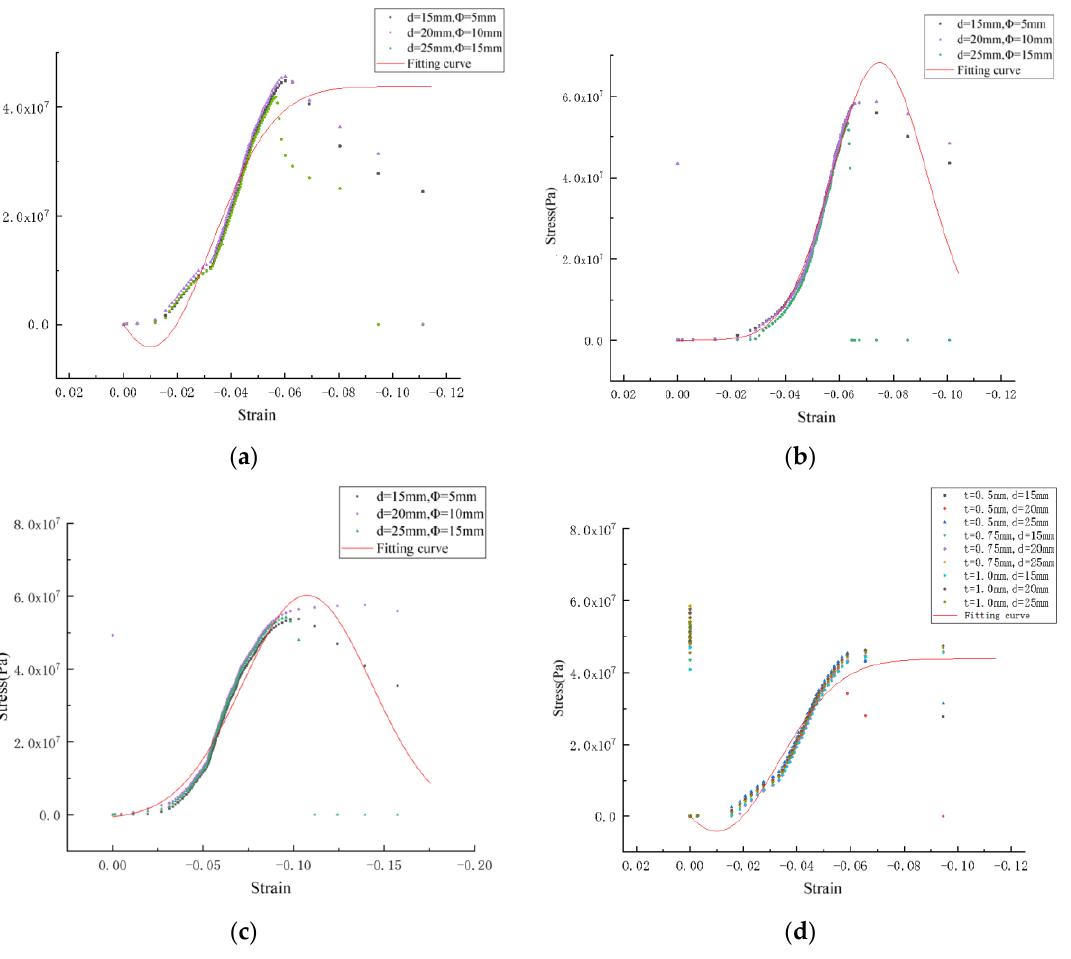
Figure 11. Stress – strain curve of perforated steel sheet concrete: ( a ) thickness of 0.5 mm; ( b ) thick- ness of 0.5 mm; ( c ) thickness of 0.5 mm; ( d ) summary of three thicknesses.